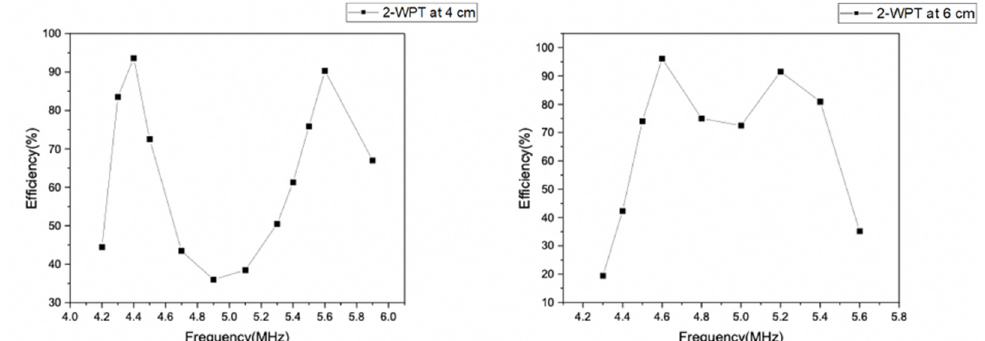
Figure 6. Transfer efficiency of the two-coil system analyzed in a frequency domain at a separation of 4 cm ( left ) and 6 cm ( right ).